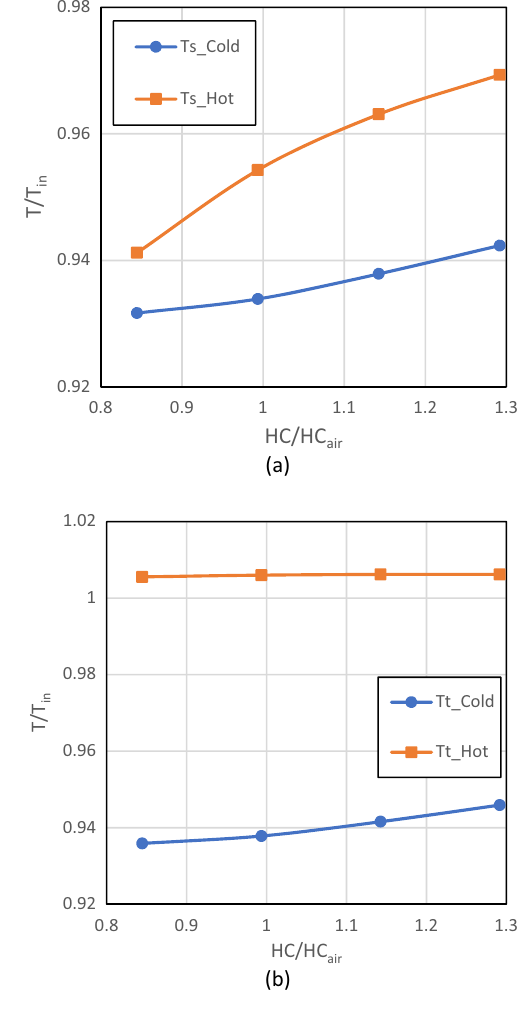
Fig. 13 Effect of heat capacity ratios on dimensionless a static and b total outlet temperatures with 400 kPa at the inlet, 0 kPa at the cold outlet and 30 kPa at the hot outlet